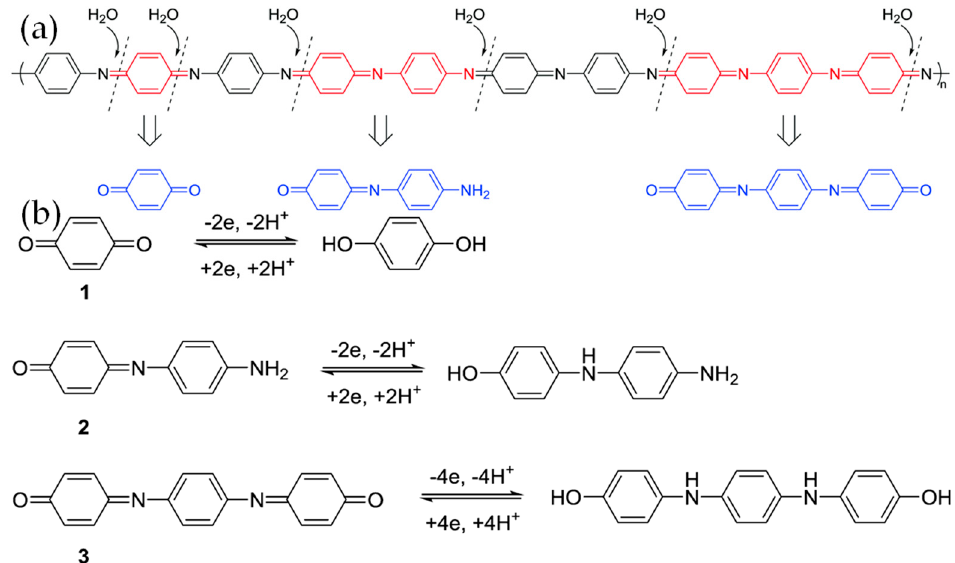
Figure 5. ( a ) Degradation of PANI during the electrochemical process; ( b ) Reversible redox reaction of HQ and HAOANIs. Reproduced with permission from [56]. The Royal Society of Chemistry (2018).